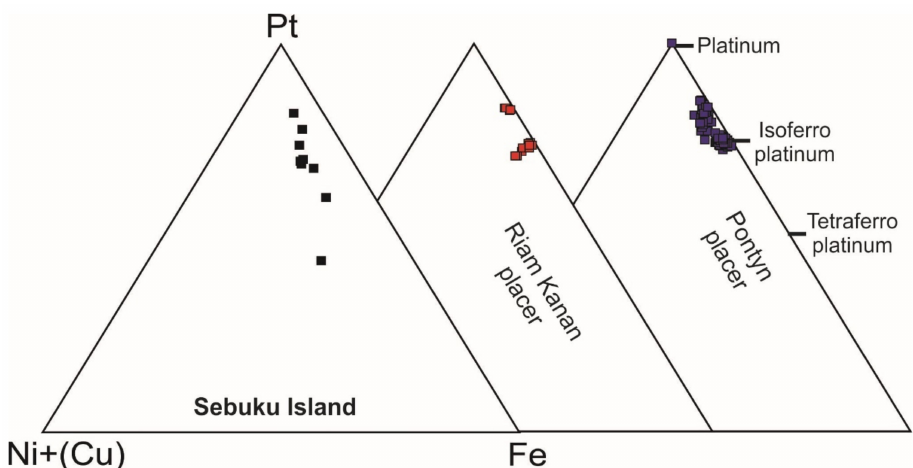
Figure 21. Pt-Fe-Ni + (Cu) ternary diagram of the compositions (atomic %) of the Pt-bearing alloys from the Sebuku high-Al chromitites and compared with those from the placers of Riam Kanan and Pontyn